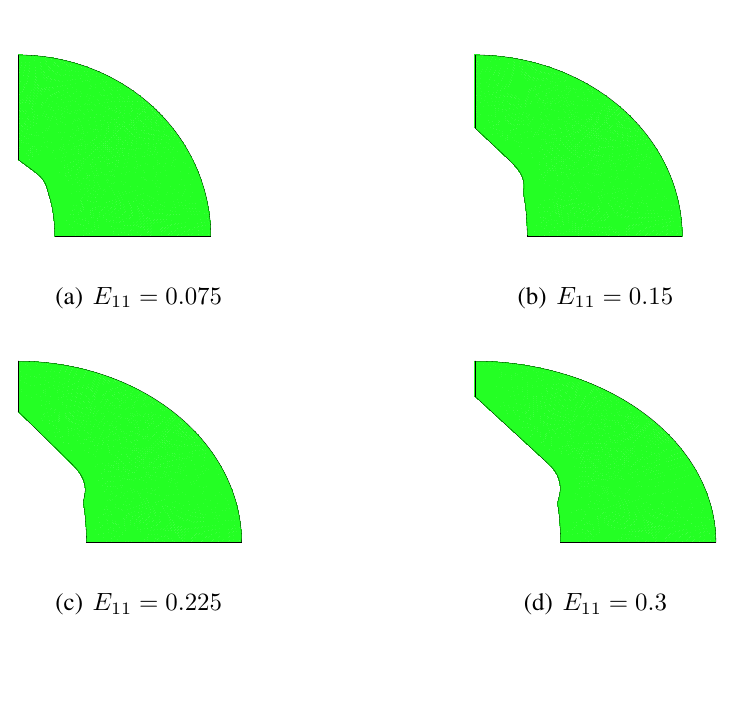
Figure 6 . f = 0 . 01 , λ = 3 . Microstructure evolution under k 0 0 unit-cell simulation.